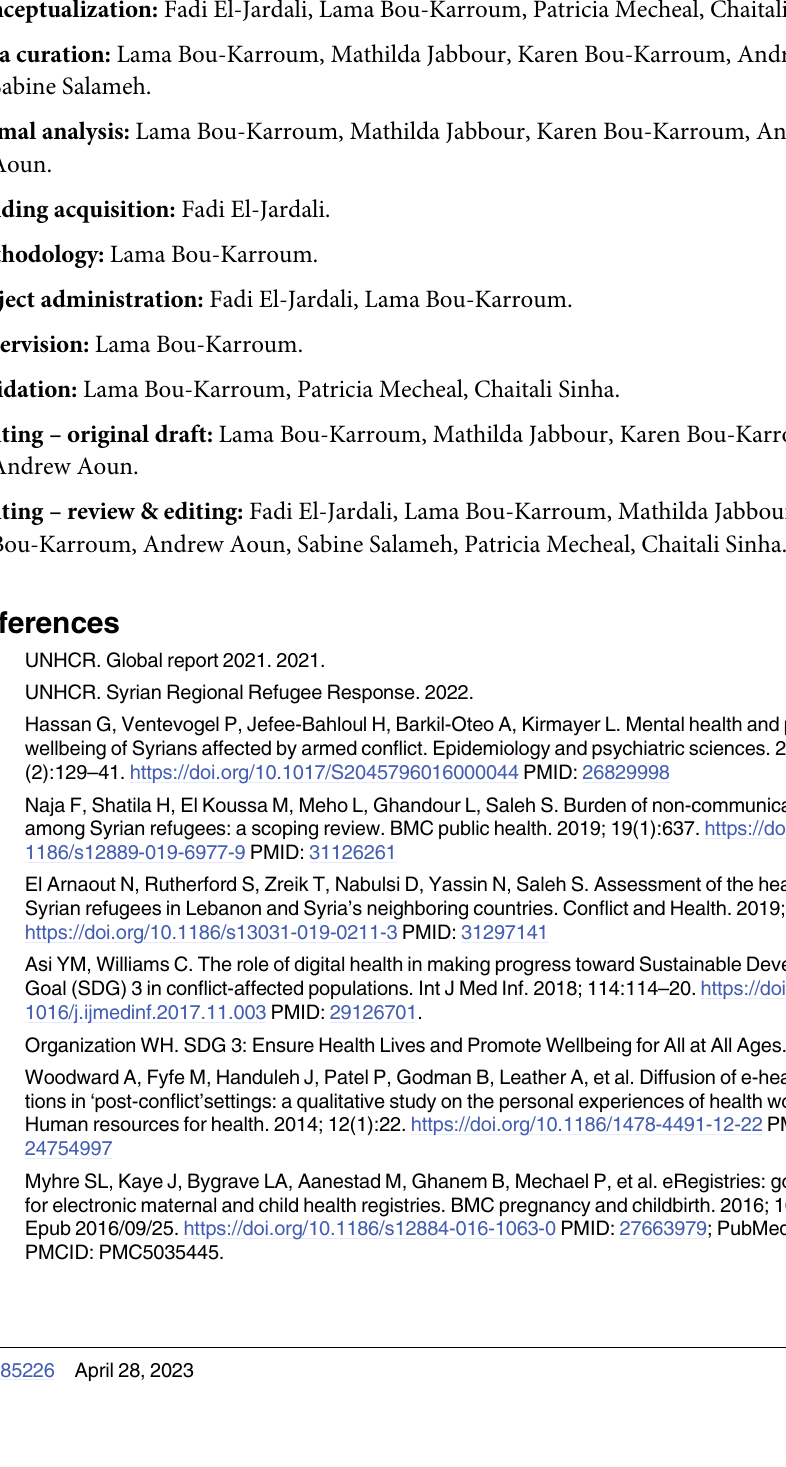
S3 Table. Studies on data services. S4 Table. Studies on health providers and clients. S5 Table. Studies on health systems or organizations